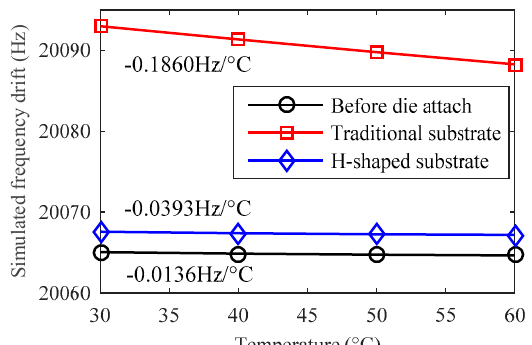
Figure 4. The simulated temperature drift of a single resonator’s natural frequency dominated by the thermal stress in design A.